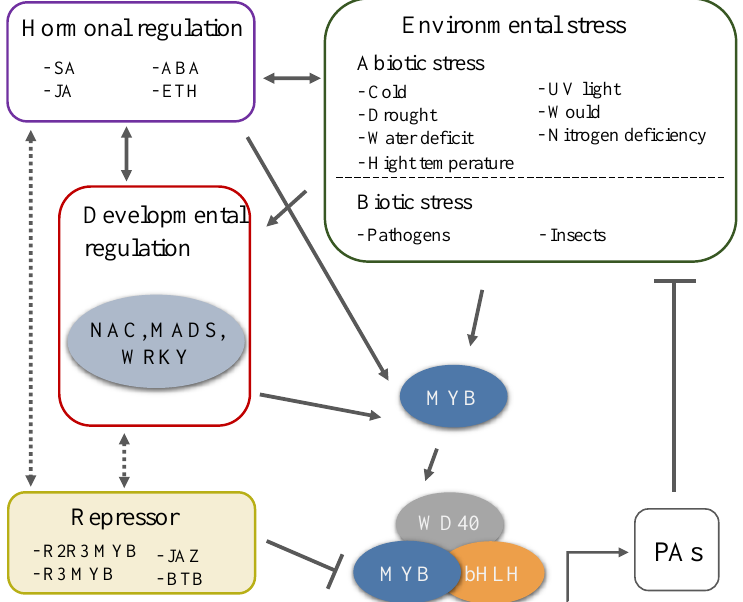
Figure 3. Environmental and developmental regulation of PAs biosynthesis through the MBW complexes. A large number of MYBs regulate the synthesis of PAs that are involved in plant response to stress and signals. Plant hormones are response to the environmental and developmental cues, and are the key factors involved in PAs biosynthesis. Environmental stresses a ff ect the accumulation of PAs, and the high levels of PAs further enhance plant tolerance to extreme environmental challenges.